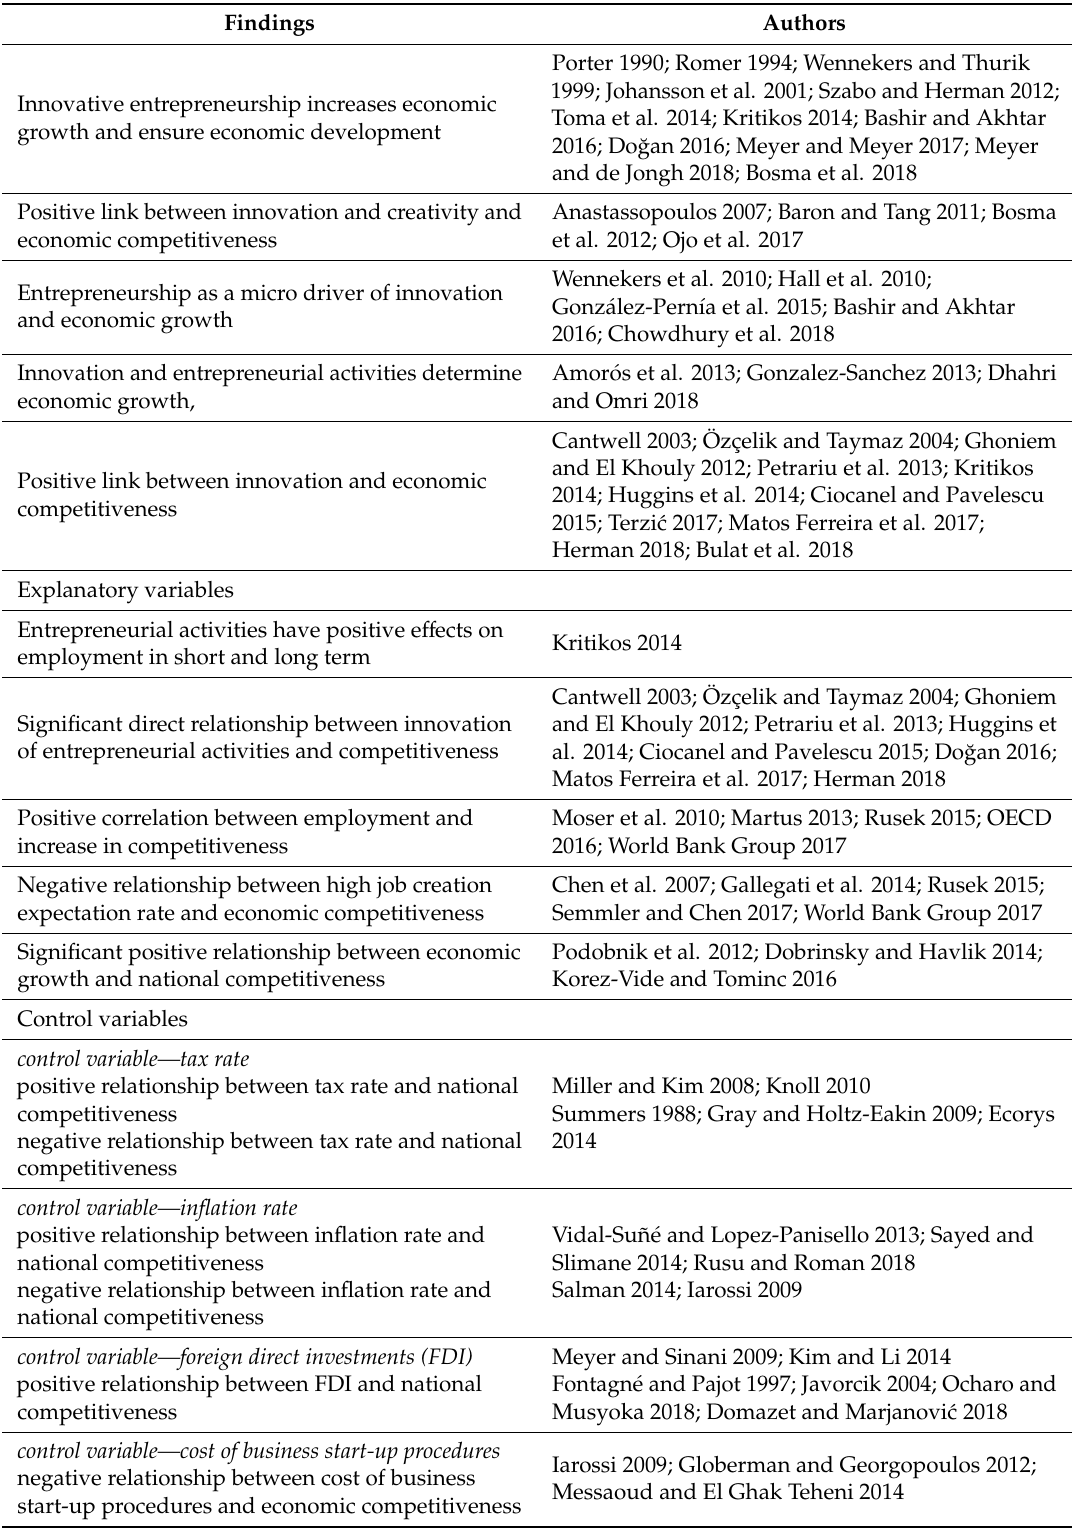
Table 1. Authors included in the literature review and their